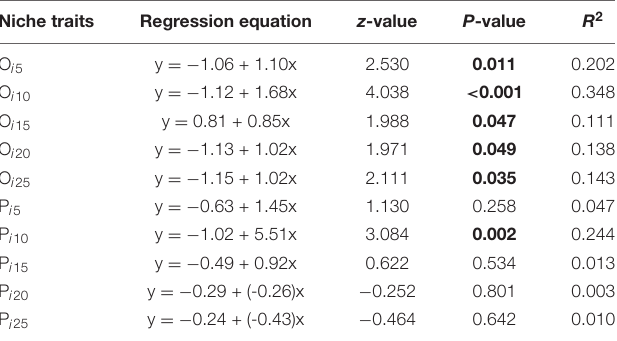
TABLE 4 | Results of Beta regression models testing correlations of response of species abundance to fertilization (R f ) with traits of temperature niche for